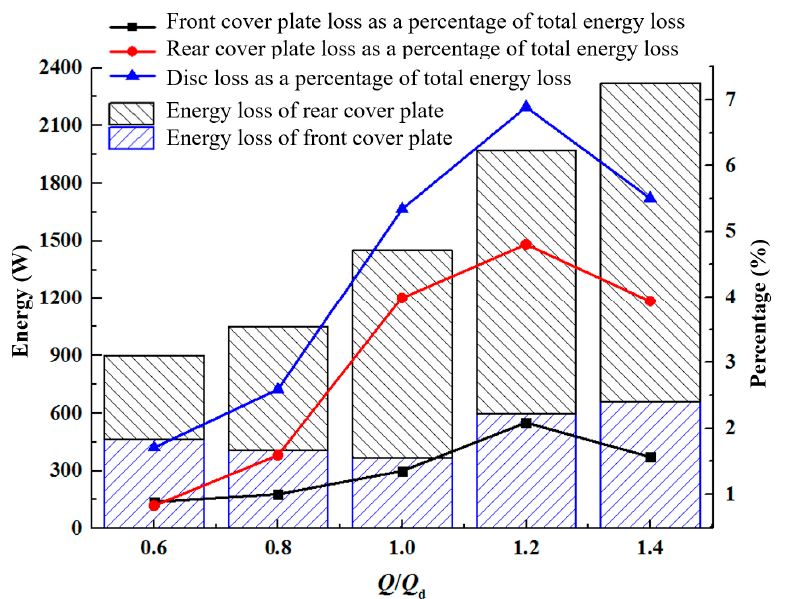
Figure 12. Statistical chart of disc loss.